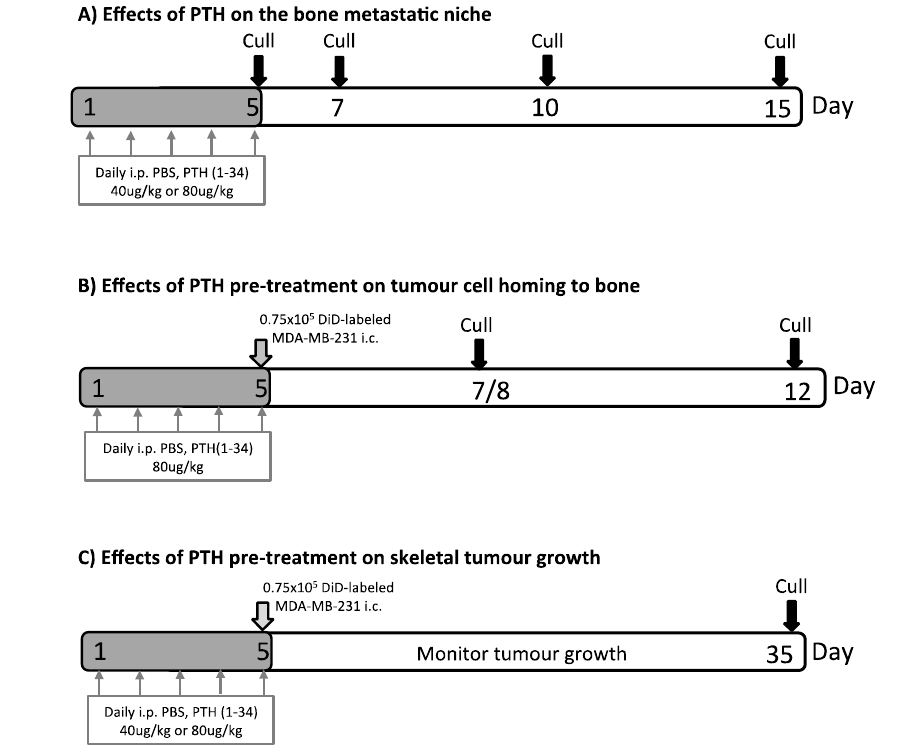
Figure 1. Experimental outlines. Twelve-week-old female BALB/c nude mice were used in all experiments. Mice were injected with PBS, 40 μg/kg or 80 μg/kg PTH daily for 5 days as indicated. In ( A ) effects of PTH treatment on bone volume, serum bone remodeling markers and bone cell numbers were determined. ( B ) To assess tumour cell homing to the long bones, animals were injected with 0.75 × 10 5 DiD-labeled MDA-MB-231-tomato-luc2 cells 4 h after the last PTH injection on day 5. Samples were collected on day 7/8 and 12 before analysis of DiD-positive events in the bone marrow of the proximal tibia using two-photon microscopy. ( C ) Animals were treated with PTH and injected with tumour cells as described in ( B ). Investigation of effects of PTH pre-treatment on MDA-MB-231-tomato-luc2 tumour growth was performed using in vivo bioluminescence imaging and